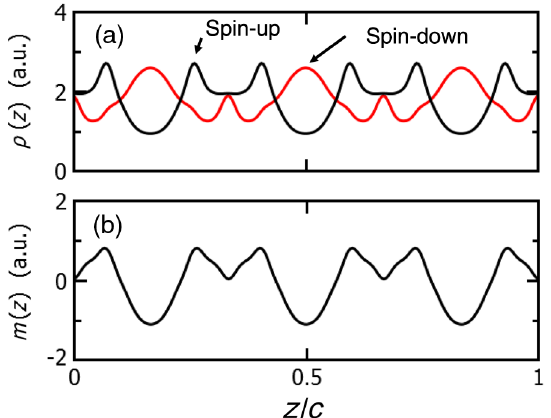
FIG. 8. (a) PED and (b) partial magnetization for Er 2 C within 0.05 eVof E F averaged over the ab plane ( U ¼ 6 . 7 eV, J ¼ 0 . 7